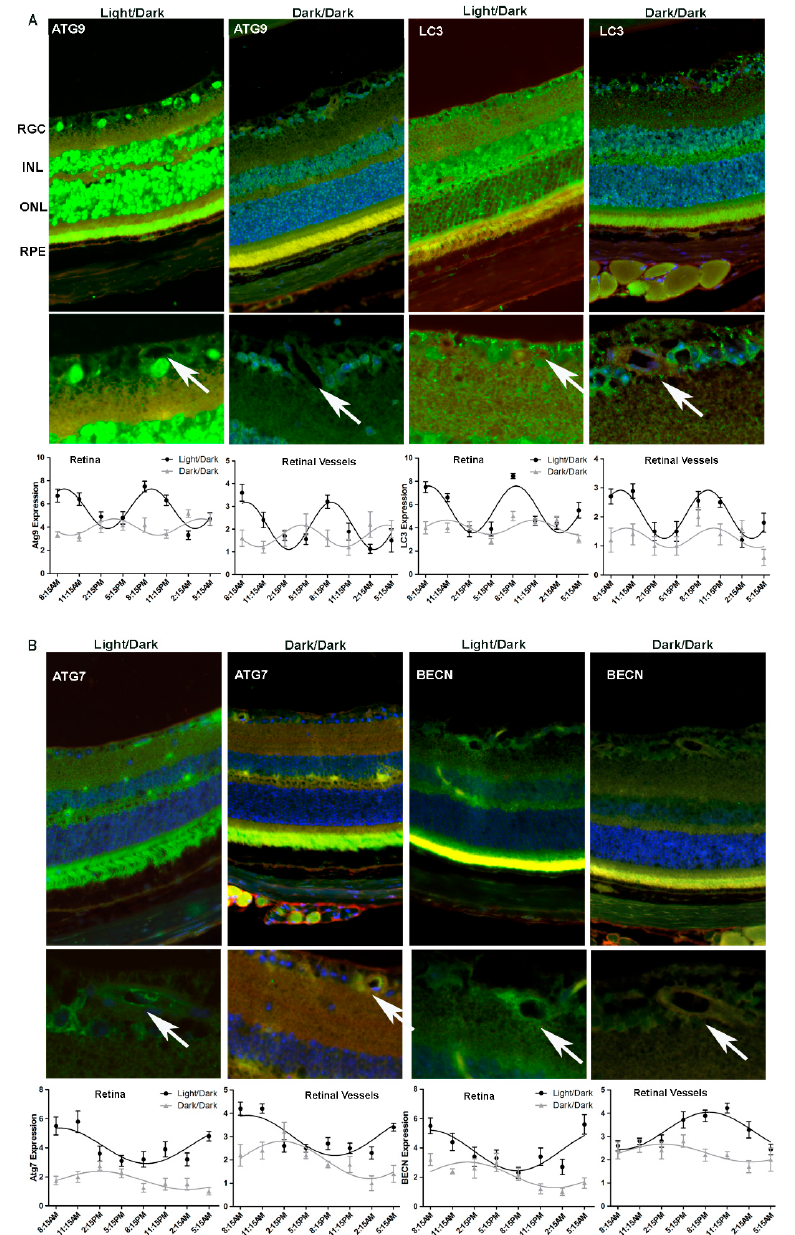
Figure 3. Immunohistochemistry confirmed alterations in diurnal patterns of autophagic gene expression upon light cycle